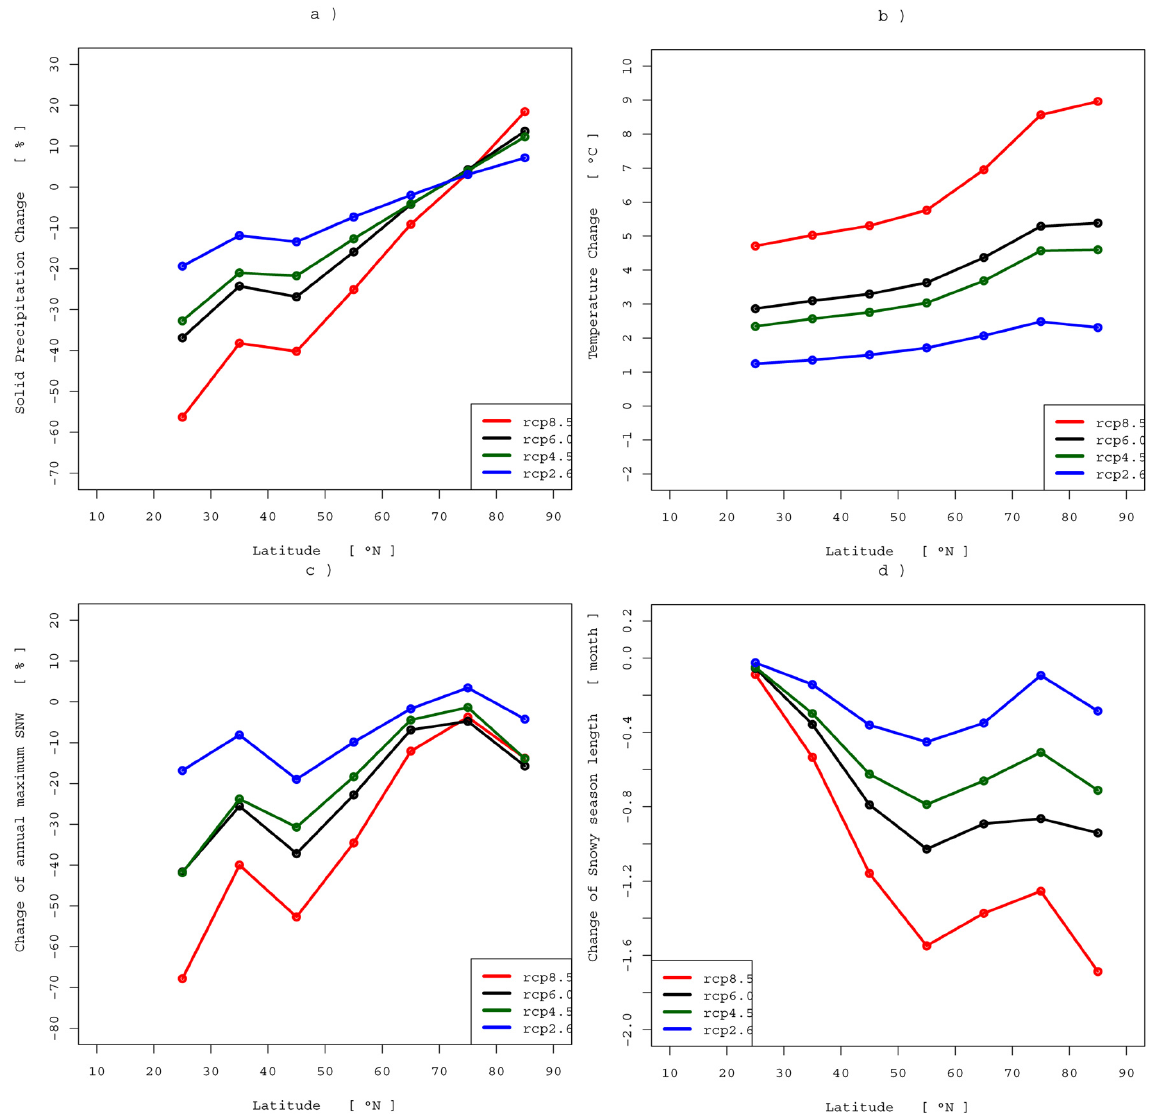
Fig. 8. Zonal mean multi-model mean simulated changes, from the end of the 20th to the end of the 21st centuries, of (a) solid precipitation, (b) temperature, (c) annual maximum snow water equivalent and (d) snow season length for continental grid points as a function of latitude (10 ◦ latitude bands centered at 25, 35, 45, 55, 65, 75, and 85 ◦ N) for the four